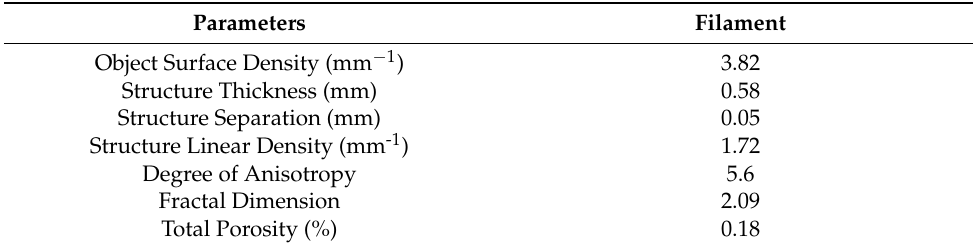
Table 2. Micro-CT arithmetical results for the filament.